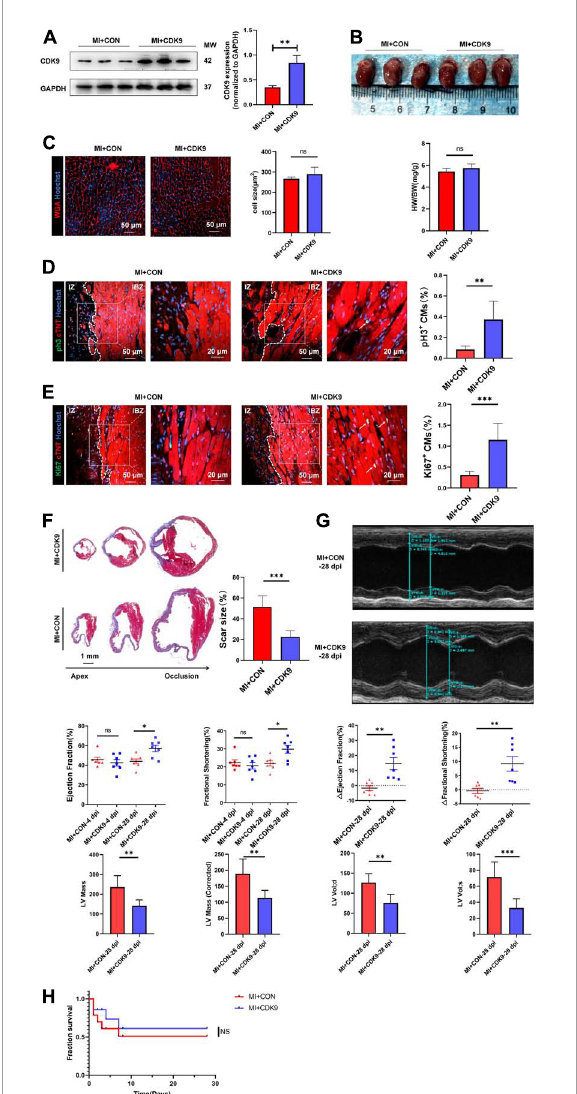
FIGURE5 CDK9 overexpression promotes myocardial regeneration after MI in adult mice. (A) CDK9 protein of ventricular myocardium in adult mice injected with AAV9: cTnT-CDK9 or AAV9: cTnT-CON after MI detected by western blot (MI + CDK9 or MI + CON). (B) Left: cardiac morphology in adult mice subjected to MI + CDK9 or MI + CON at 14 dpi. Right: heart weight/Body weight (HW/BW) ratio in adult mice subjected to MI + CDK9 or MI + CON at 14 dpi ( n = 6). (C) CM size in adult mice subjected to MI + CDK9 or MI + CON at 14 dpi was detected by wheat germ agglutinin (WGA) immunofluorescence ( n = 6). (D,E) CM proliferation in adult myocardial tissue subjected to MI + CDK9 or MI + CON quantified by immunofluorescence for mitosis (D) and cell-cycle activity (E) ( n = 6); white arrows point to the proliferating CMs. (F) Comparison of scar size by Masson staining between the CON and CDK9 groups at 28 days after MI ( n = 6). (G) LVEF, LVFS, LV Mass and LV Vol d/s in adult MI mice at 4 and 28 days after CDK9 injection was detected by echocardiography ( n = 7). (H) Overall survival rate in adult mice from MI + CON and MI + CDK9 groups ( n = 14). Scale bars, 20/50 µ m; CM indicates cardiomyocyte, MW indicates